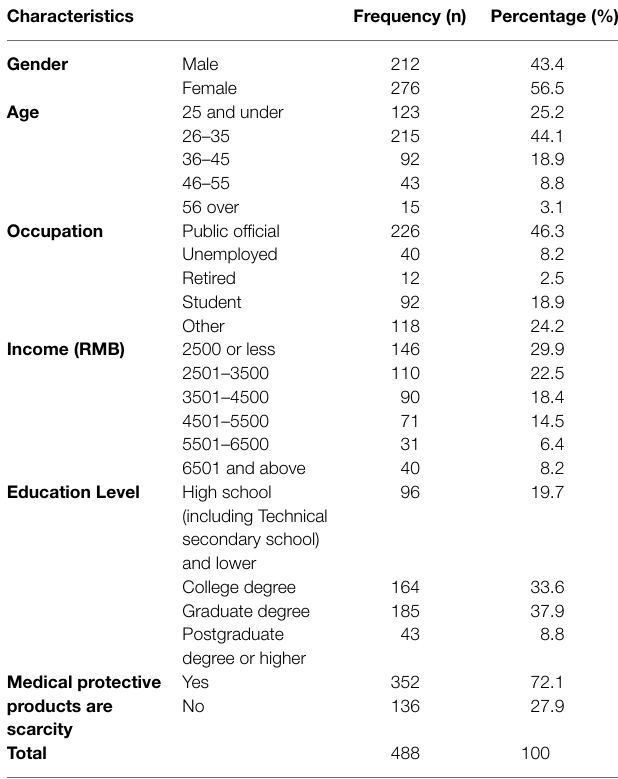
TABLE 1 | Demographic profile of respondents.